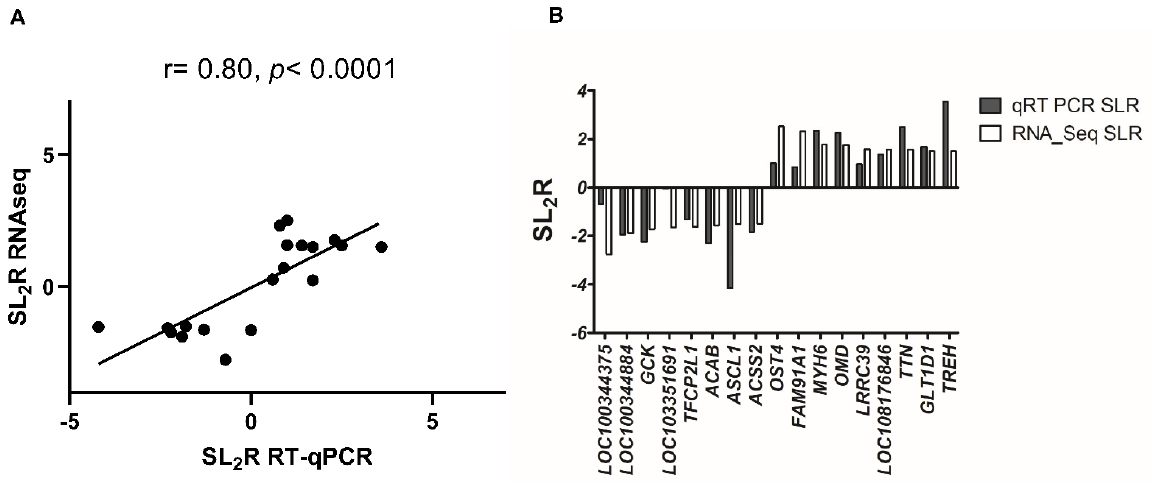
Figure 5. Concordance between used methods of RNA analysis. ( A ) Correlation analysis of 17 selected genes between RNAseq and RT-qPCR normalized to the invariant PIPB and GAPDH genes. The mean values obtained for signal log 2 ratio (SL 2 R) from individual analyses (Table 3) were plotted against the RNAseq which used partially pooled samples (Tables 1 and 2). Good agreement between the procedures was observed (r = 0.8, p < 0.0001). ( B ) Difference in results of SL 2 R expression of both procedures of the 17 selected genes.